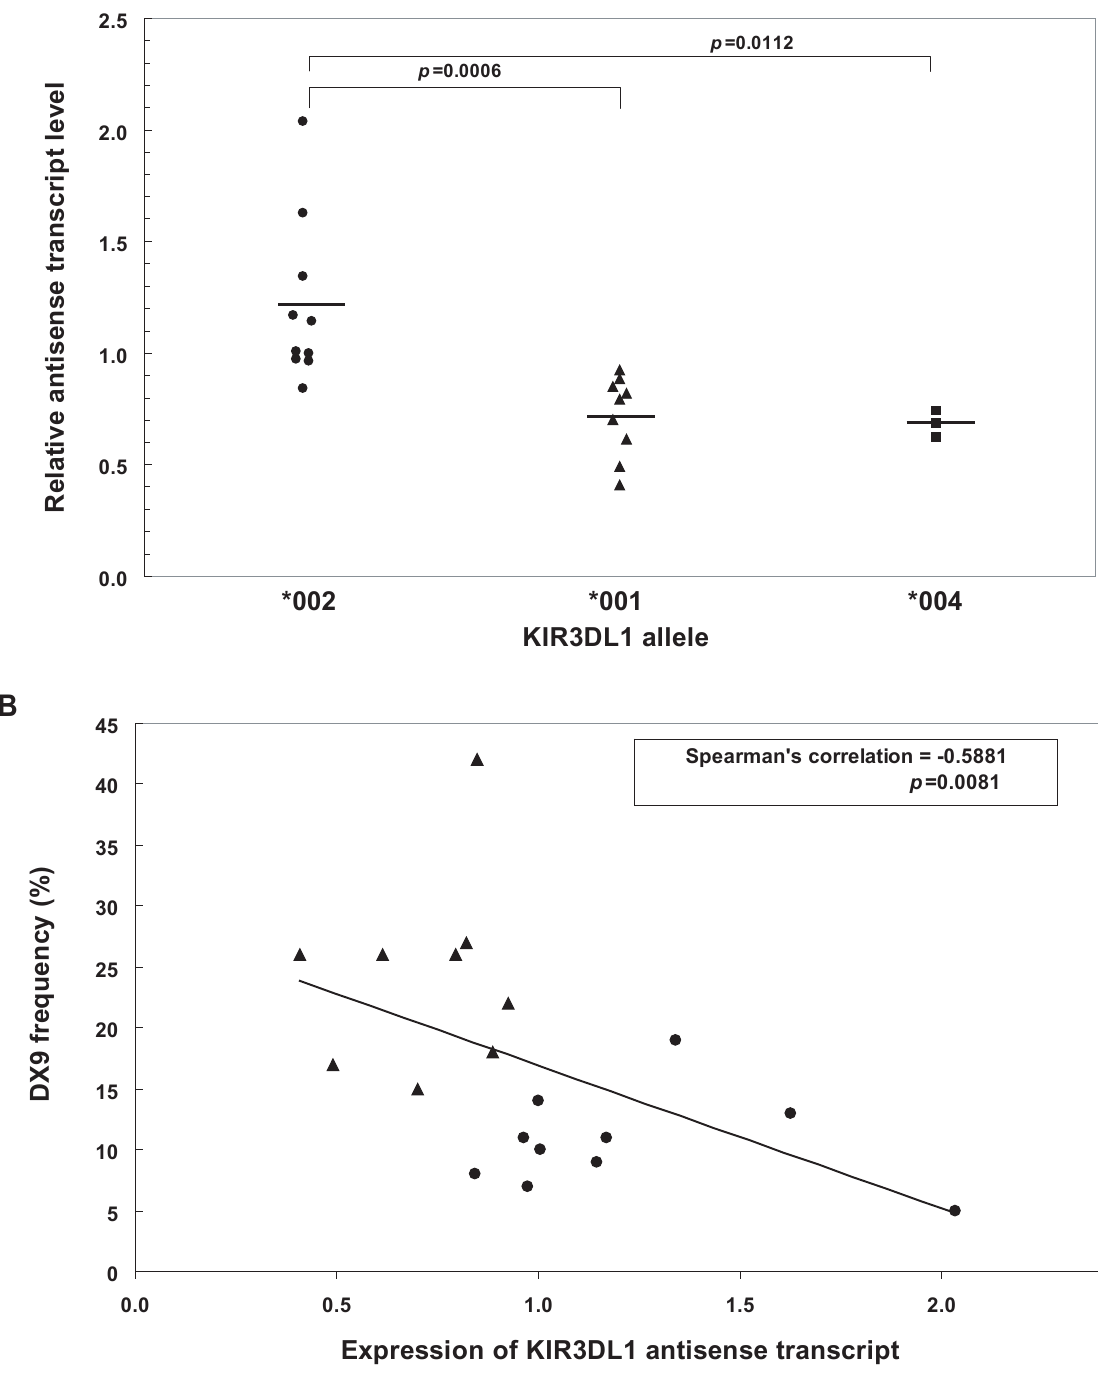
Figure 4. Quantitative analysis of KIR3DL1/S1 antisense transcripts. (A) Comparison of relative antisense transcript levels in individuals bearing alleles shown to have high (*002) or low (*001/*004) antisense promoter activity in vitro . (B) Correlation of relative antisense transcript levels with frequency of NK cells expressing different KIR3DL1 allotypes. Symbols shown correspond to individuals possessing the KIR alleles as shown in A. The KIR3DL1*004 allele was removed from the analysis since it is not expressed on the NK cell